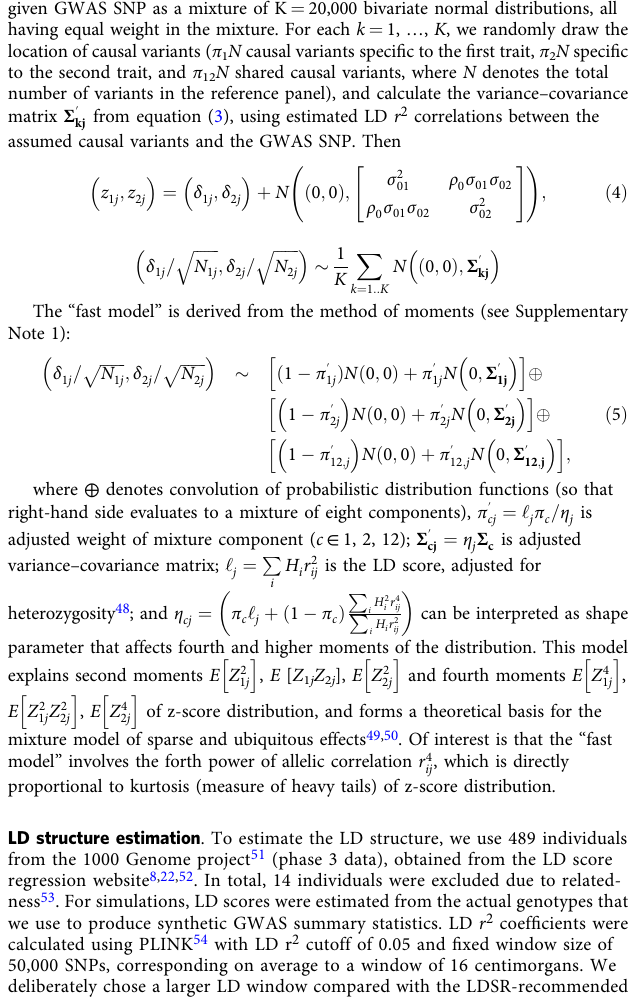
Genetic correlation . Parameter ρ 12 in MiXeR de fi nes the correlation of effect sizes within the shared polygenic component. Genome-wide genetic correlation,